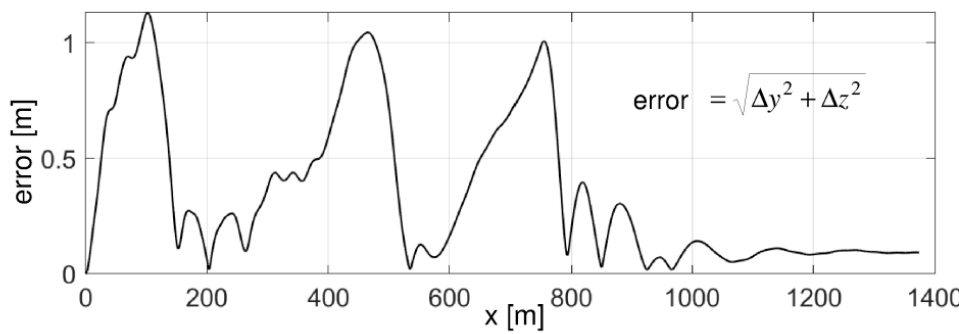
Figure 6. The performed and set flight trajectory in ( a ) the vertical plane; ( b ) the horizontal plane.